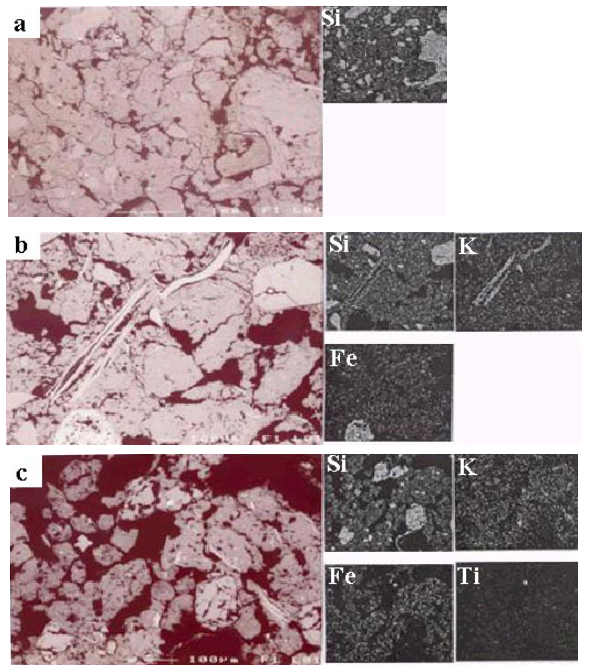
Figura 4. Fotomicrografias em retroespalhamento eletrônico, ilustrando a microestrutura e algumas pedofeições selecionadas no horizonte Bw de P2.